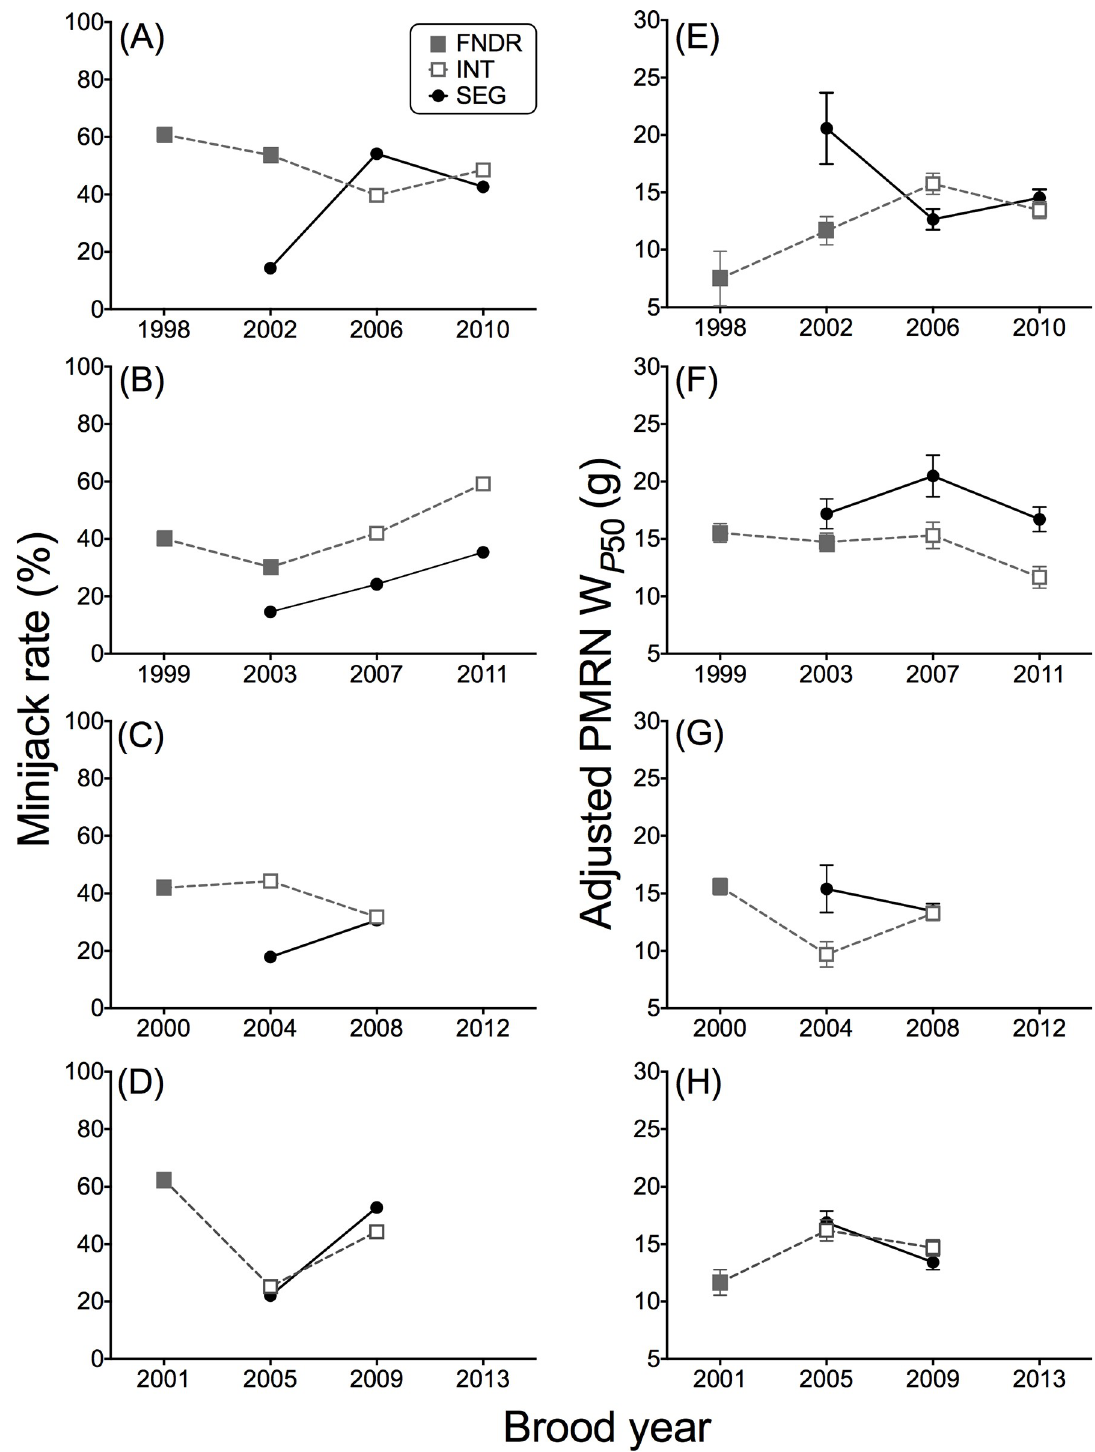
Fig 6. Across generation examination of age-2 minijack rate and PMRN W P50 estimates. (A-D) Age-2 minijack rates and adjusted PMRN W P5 0 estimates with SEM (E-H) by broodline across generations for the founding (FNDR) brood years (BYs 1998–2001). A majority of the spawning Chinook salmon returning to the Yakima River are age-4 adults, thus generation time for each cohort is approximately 4 years. See Fig 4 for FNDR, INT, SEG